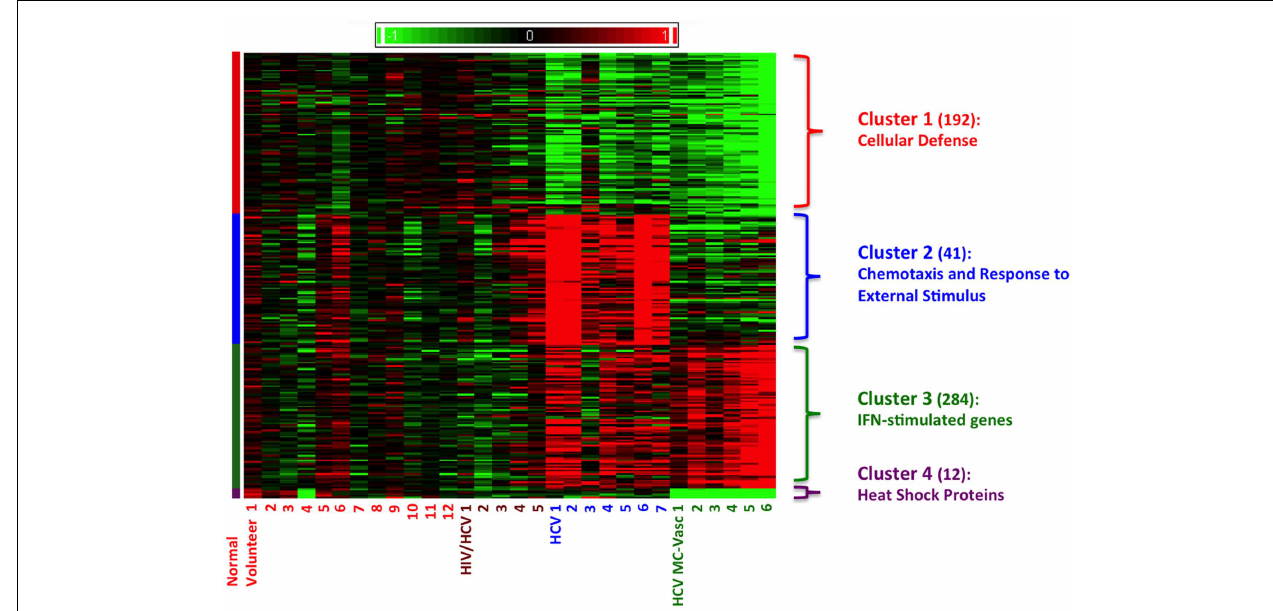
green indicates down-regulation relative to that of corresponding gene expression in controls.The numbers in parentheses specify the number of genes in each cluster. Cluster 1 consists of genes down-regulated in HCV monoinfected patients and HCV MC vasculitis patients. Cluster 2 consists of genes up-regulated in HCV monoinfected patients without vasculitis. Cluster 3 consists of genes up-regulated in HCV MC vasculitis patients and Cluster 4 consists of genes down-regulated in HCV MC vasculitis